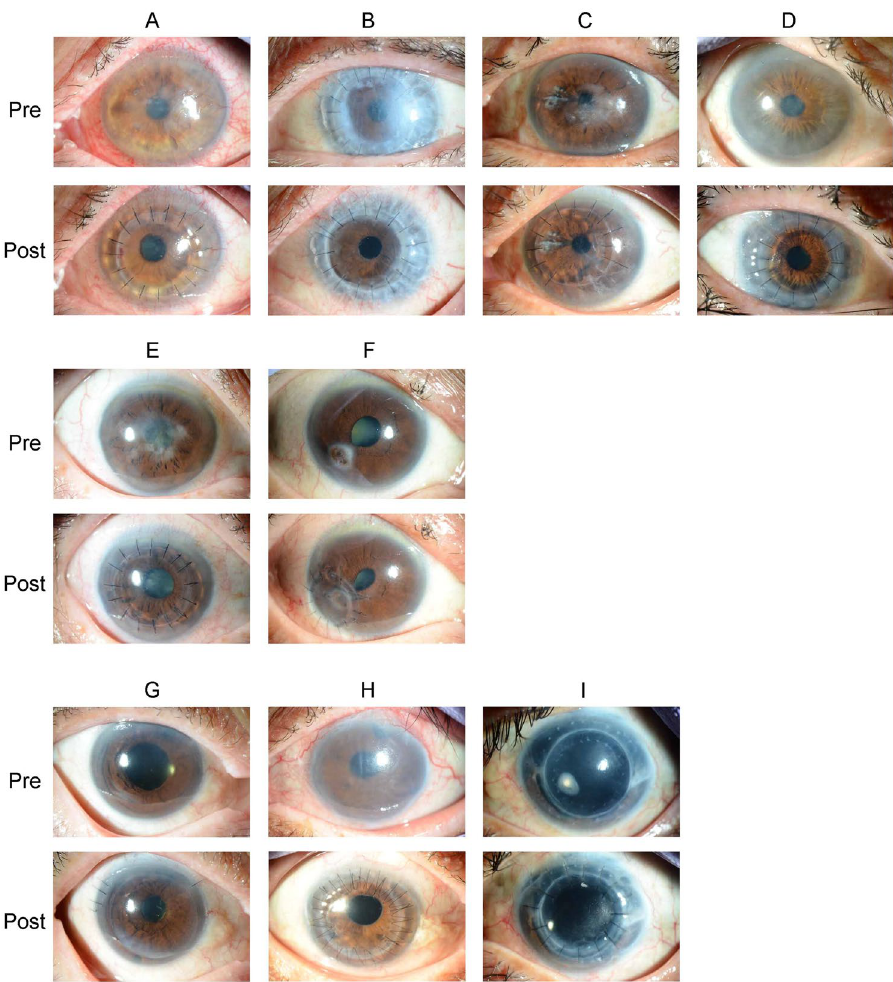
Figure 1. Details of positive PCR results in cornea recipient and donor samples. Images of the anterior segment in patients with positive PCR results. The upper images were obtained before surgery (pre) and the lower images were obtained after surgery (post). HSV-1 was detected in the extracted tissue of the herpetic keratitis patient ( A – D ). Parvo B19 was detected in the extracted tissue of the patient with bilateral corneal opacity after interstitial keratitis ( E , F ). HHV-6 was detected in the donor tissue in the patient treated for bullous keratopathy after both laser iridectomy and intraocular surgery ( G , H ). Aspergillus was detected in the storage solution of the donor cornea used in the patient treated for bullous keratopathy after graft failure ( I ). HHV-6 = human herpes virus type 6; HSV-1 = human simplex virus type 1; Parvo B19 = human parvovirus B19 ; PCR = polymerase chain